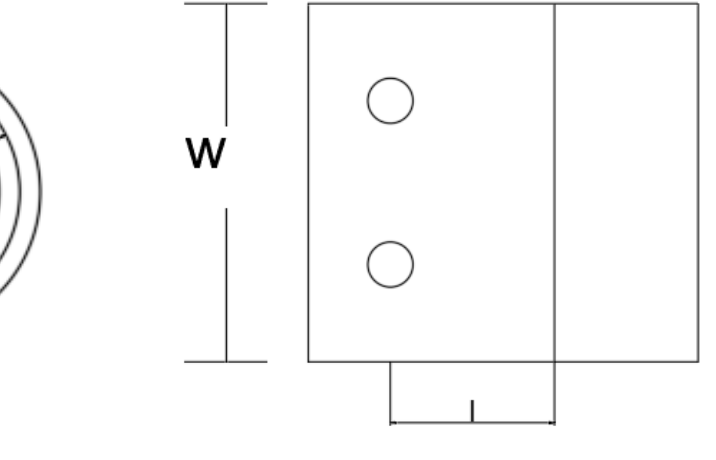
Figure 6. Damper construction. Table 1. Construction